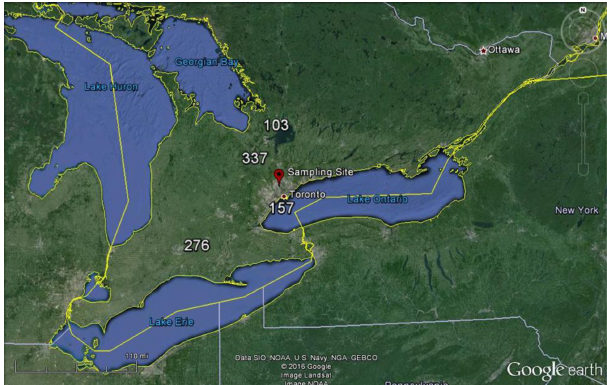
Figure 12. Location of facilities in Toronto with significant emis- sions of toluene. The numbers represent the annual emissions in tyear − 1 . Emission data were taken from the National Pollutant Re- lease Inventory (NPRI). Only sources contributing at least 5% to the total emissions are shown. Also shown is the location of the sam- pling site. The map was produced using Google Earth ( ©